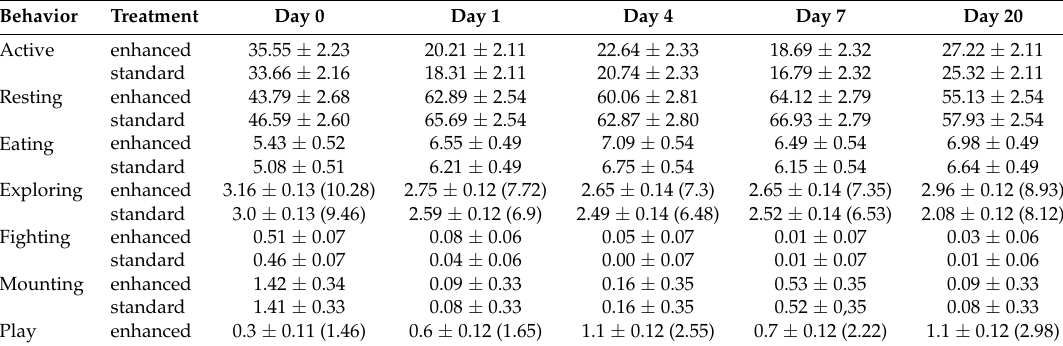
Table 4. The proportion of time spent in continuous behaviors in sows in enhanced and standard group pens in the days following a mixing event * ,1